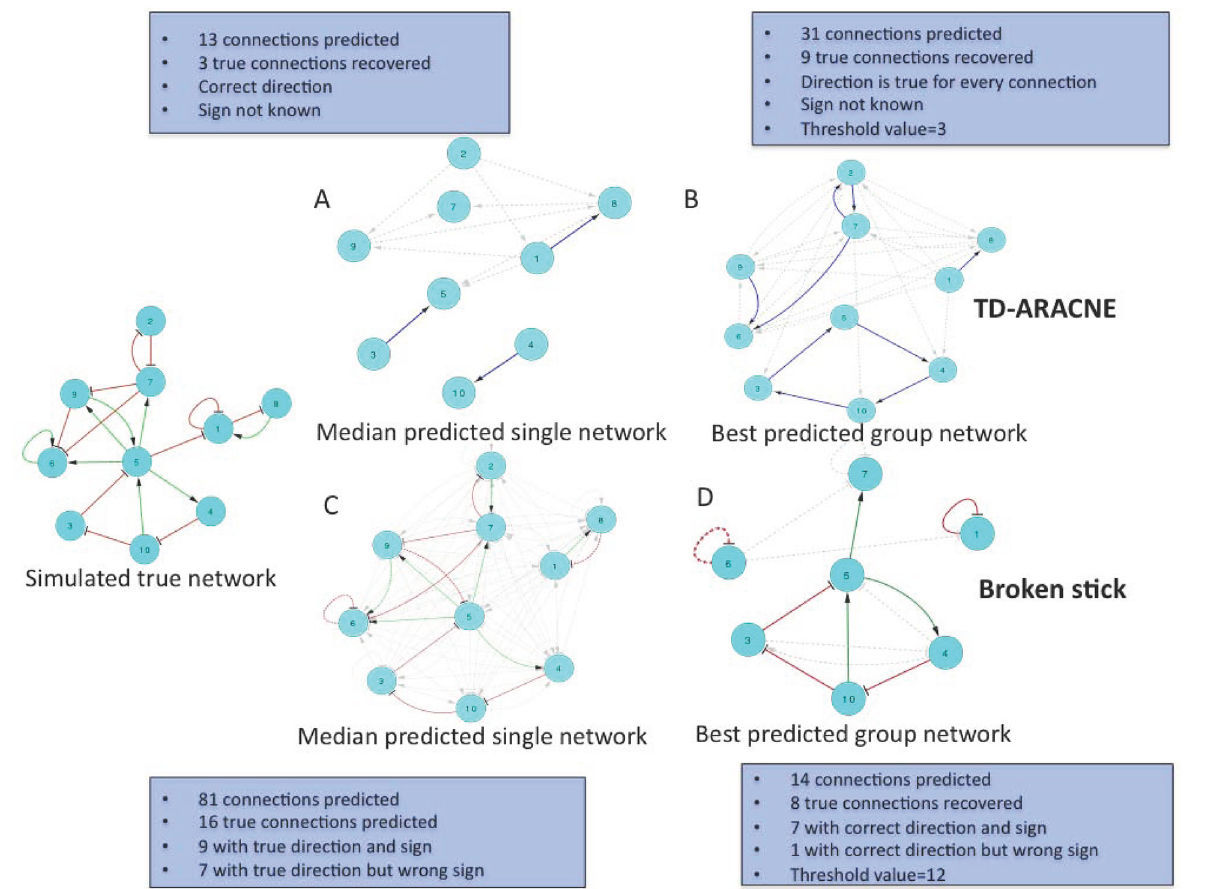
Fig 1. Recovery of an example 10-node network. (A) Median inference by TD-ARACNE using single time course, (B) best possible inference by TD-ARACNE using a group of 15 simulated time courses for the same network, (C) Median inference by broken stick using single time course and (D) best possible inference by broken stick using a group of 15 simulated time courses for the same